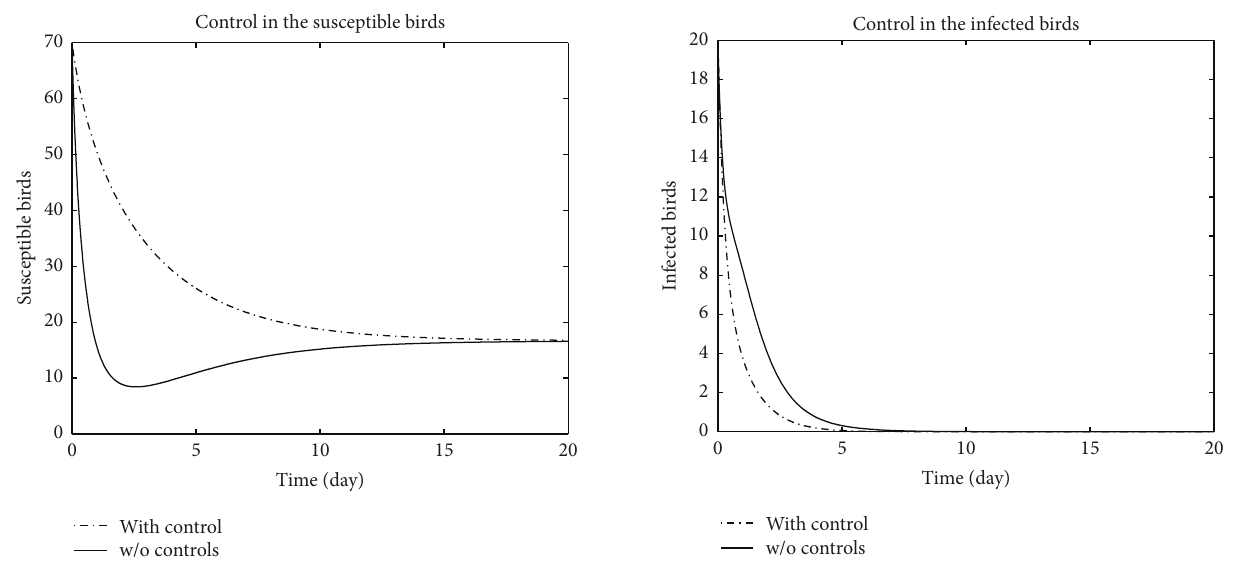
Figure 8: The plot represents the population of infected birds with and without control.